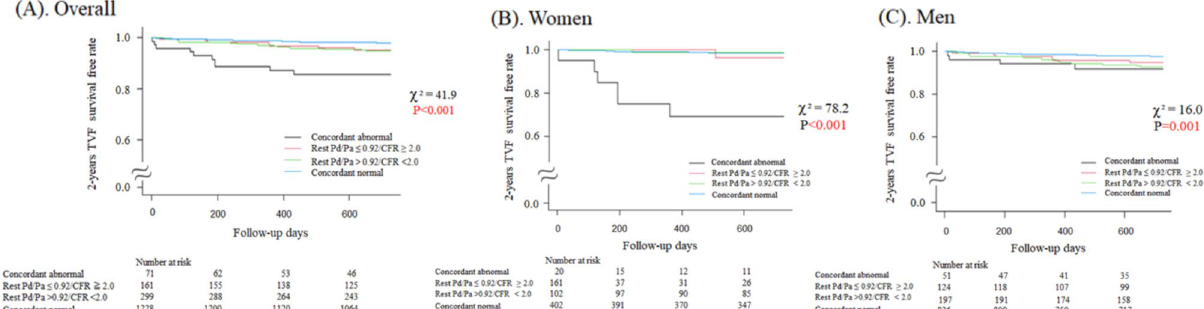
Figure 3. Kaplan–Meier time to event curves for target vessel failure during 2-year follow-up across the groups defined by normal/abnormal resting Pd/Pa and CFR. The 2-year TVF survival free rate was compared across the groups defined by normal/abnormal resting Pd/Pa and CFR in ( A ) overall cohort, ( B ) women, and (C ) men. CFR Coronary flow reserve. Other abbreviations are listed in Fig. 1.